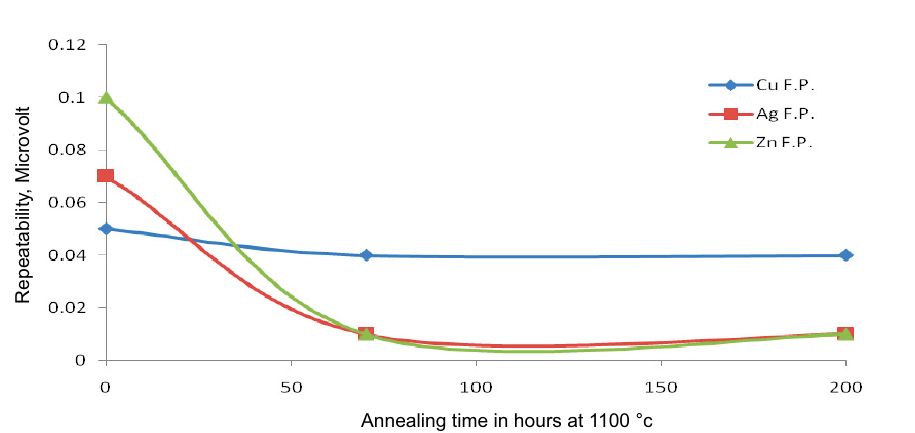
Fig. 3. Repeatability Pt/Pd thermocouple at Zn, Ag and Cu freezing points after different heat